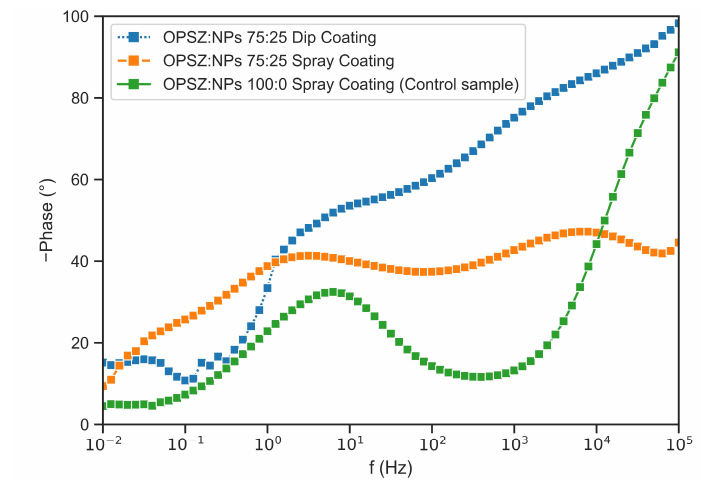
Figure 13. Bode phase.